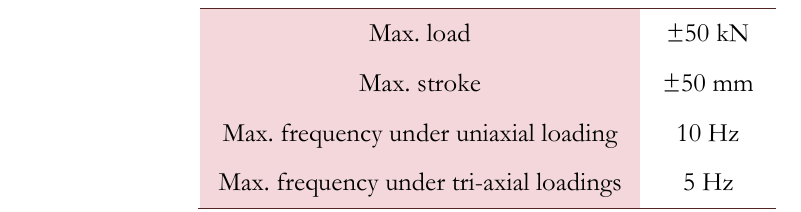
Table 1: Specifications of planar tri-axial fatigue testing machine.